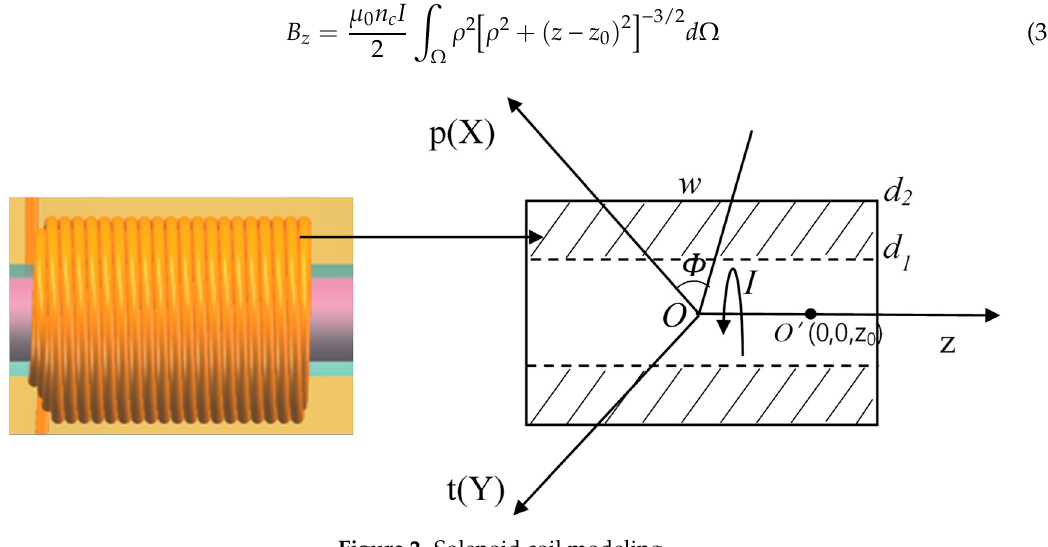
Figure 2. Solenoid coil modeling.